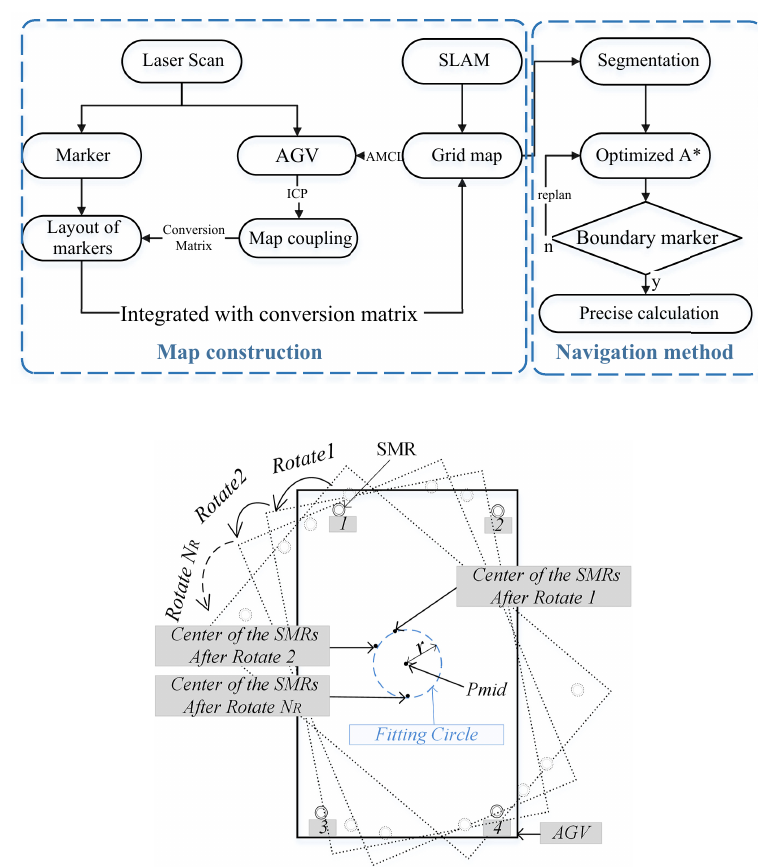
Figure 2. The fitting circle measurement method isproposedforfiguring out the geometric center of